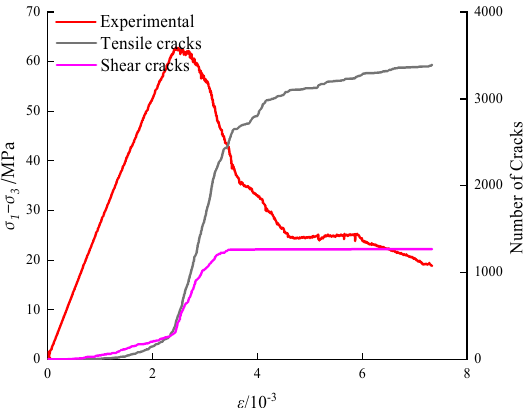
Figure 17. Crack evolution during triaxial loading with bedding angle 0°.